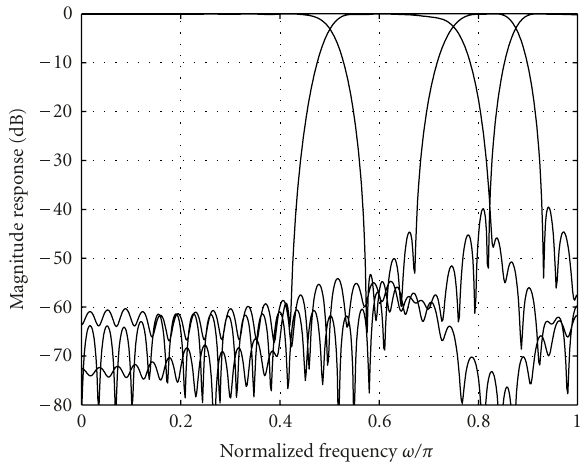
Figure 6: Magnitude responses of the transmitting filters (no fre- quency criteria).